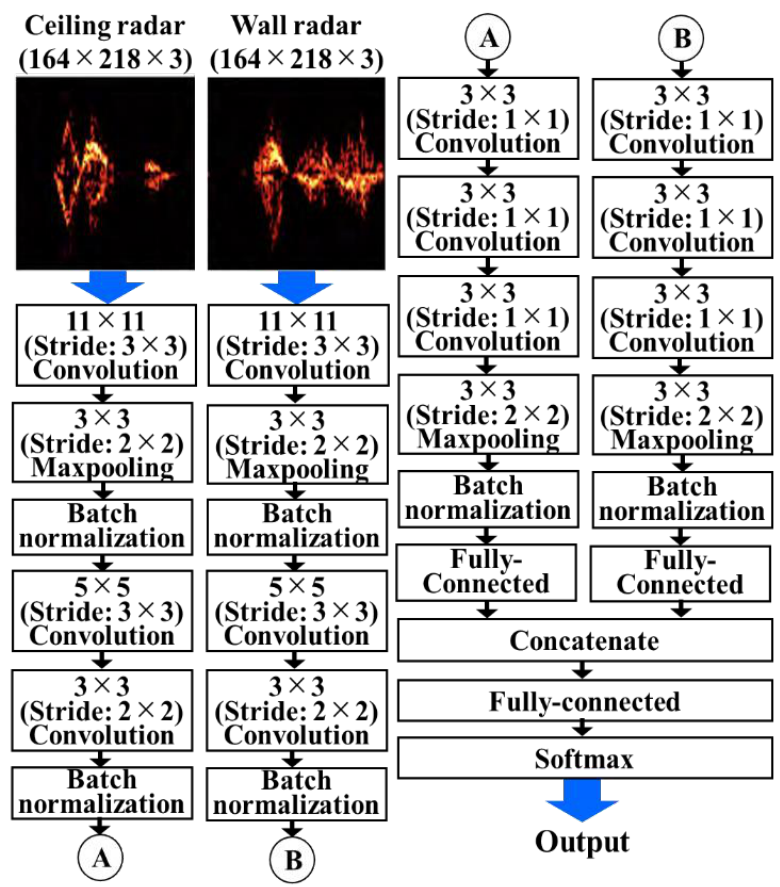
Figure 4. Process and structure of the CNN method.